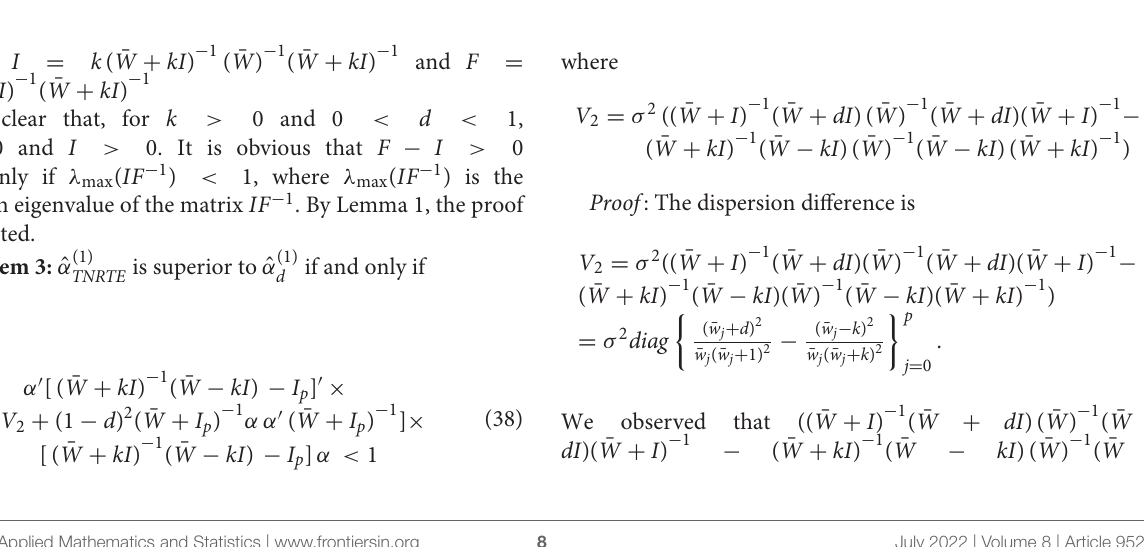
TABLE 6 | Simulation results in case of p